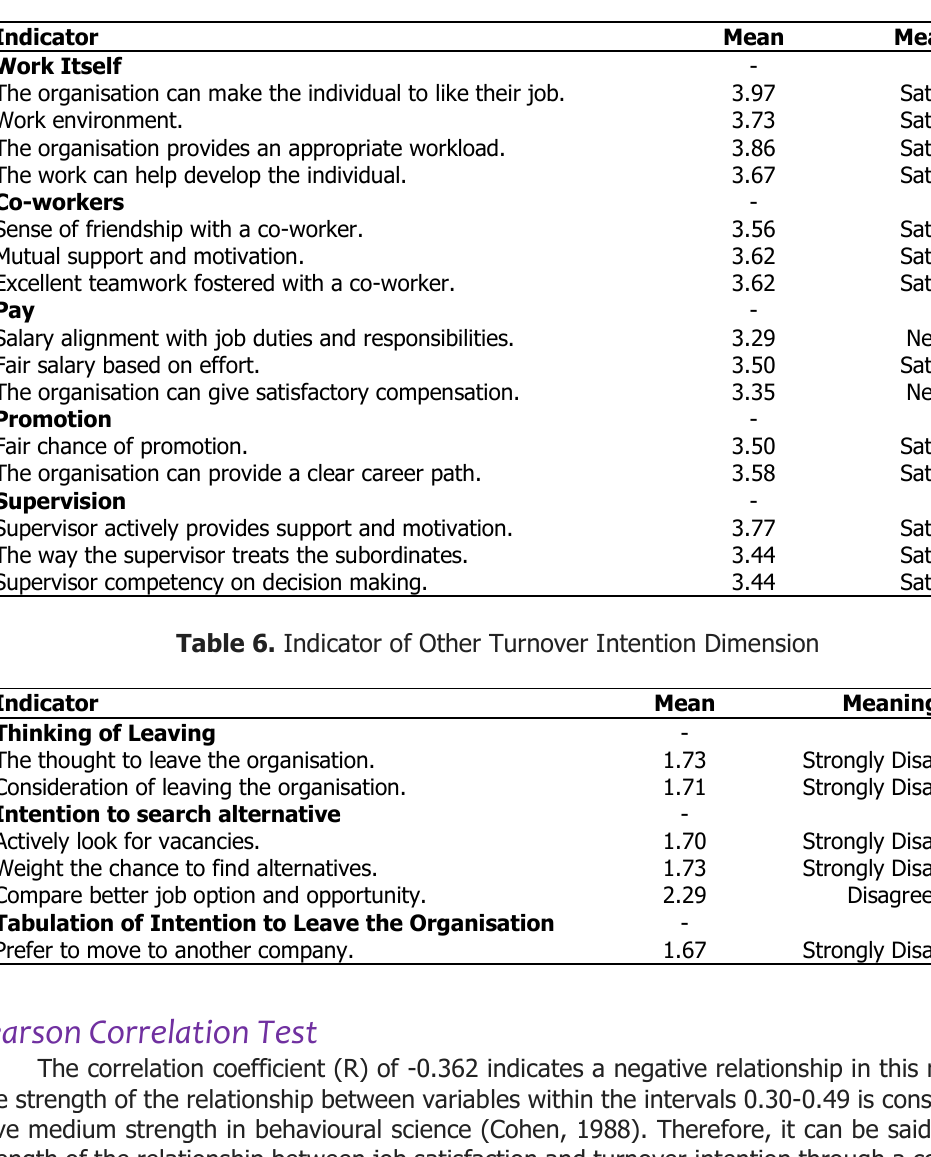
Table 4. Indicator of Other Job Satisfaction Dimension